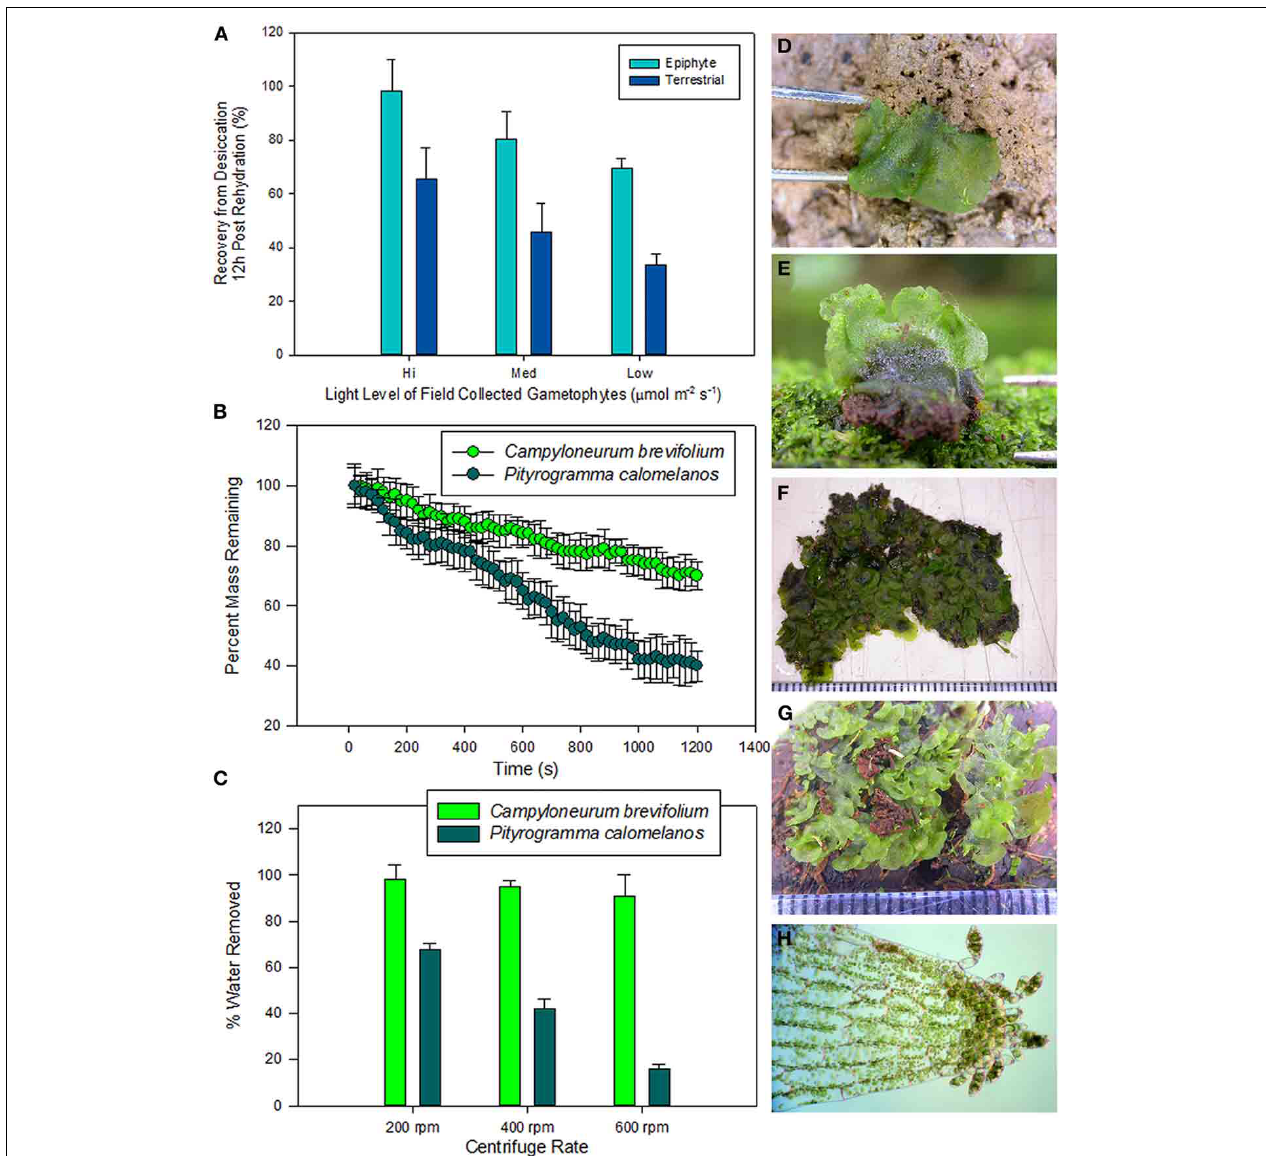
FIGURE 4 | (A) Desiccation recovery survey of 20 species of field-collected fern gametophyes from the La Selva Biological Station in Costa Rica. Species were dried to equilibrium at − 94MPa and remained in that state for 96h. Gametophytes were then rehydrated and measurements of chlorophyll fluorescence ( F v / F m ) were taken 12h post rehydration. (B) Gametophyte drying curves of two fern species: Campyloneurum brevifolium a high light epiphyte that produces three-dimensional and overlapping gametophytes typical of epiphytic species and Pityrogramma calomelanos a high light terrestrial species that produces cordiform gametophytes typical of terrestrial